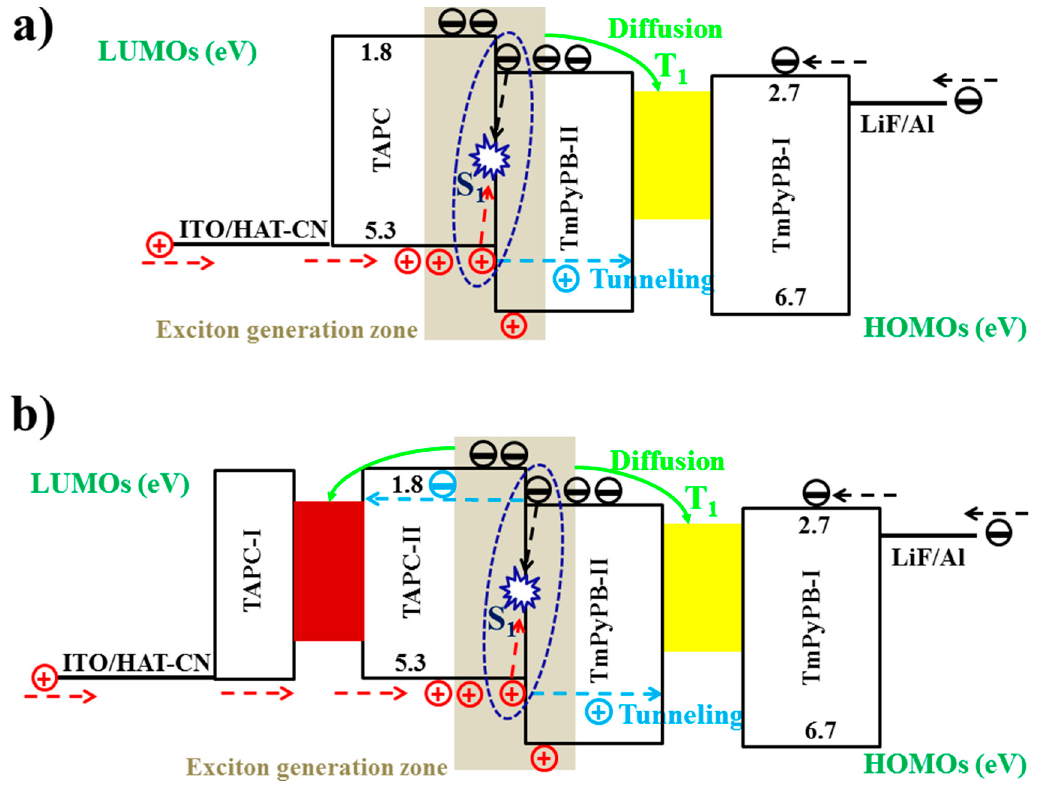
Figure 29. Schematic illustration of the emission mechanisms of ( a ) single-molecular-emitter BMEF/DFH-WOLEDs; ( b ) two-molecular-emitter BMEF/DFH-WOLEDs. Reprinted with permission from Reference [228]. Copyright (2017) American Chemical Society.